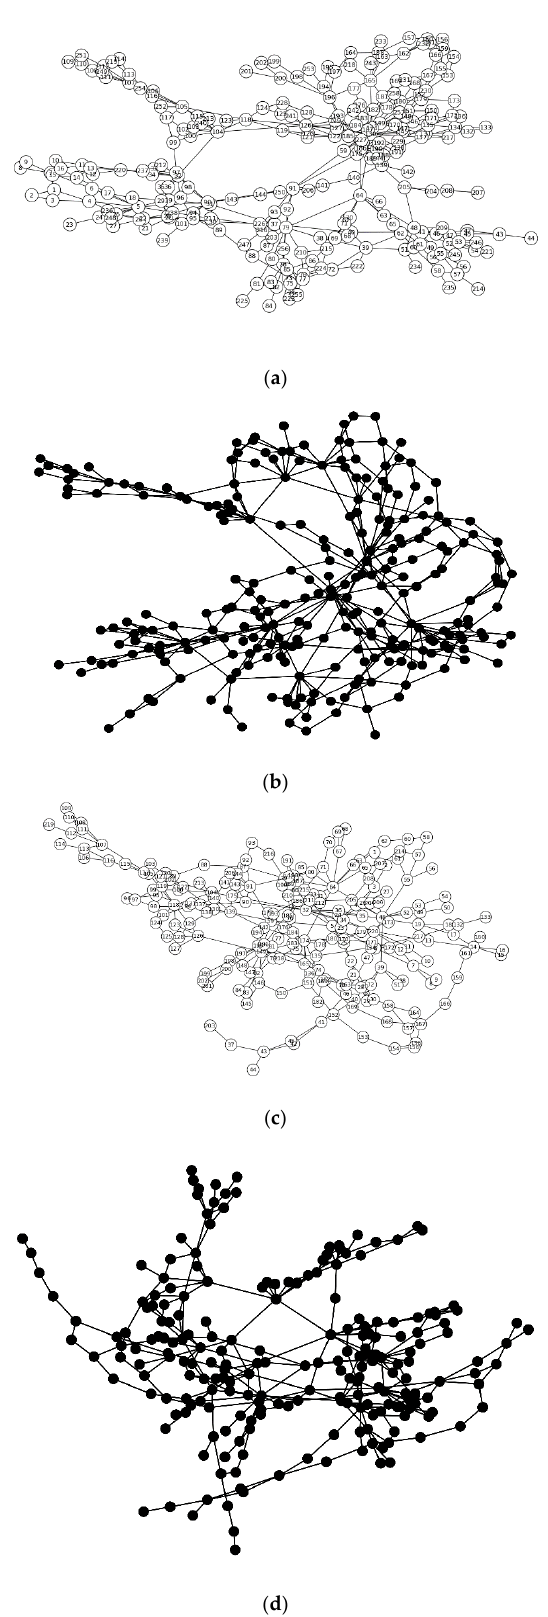
Figure 6. The power grid and the communication network of the province. ( a ) The power grid of the province; ( b ) the power grid of the province without numbers; ( c ) the communication network of the province; ( d ) the communication network of the province without numbers.